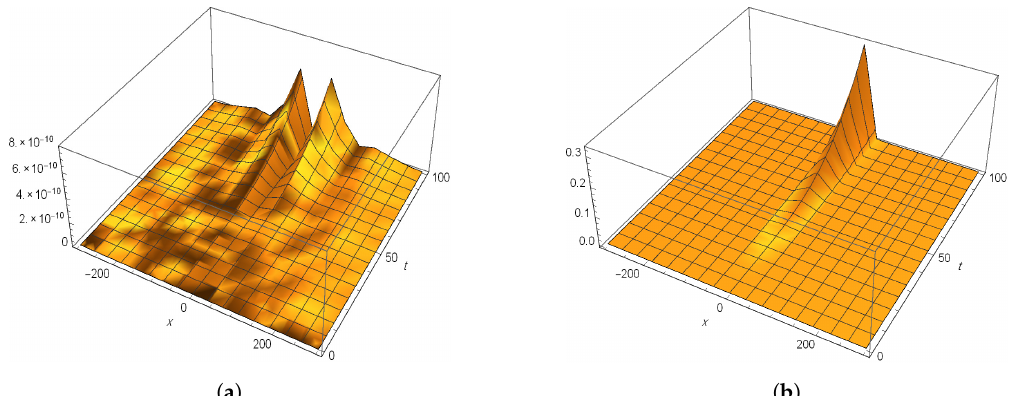
Figure 4. The absolute errors between the exact solution and third order solution for α = 1, a = 1, c = 1 with ( a ) b = 0.01 and ( b ) b =